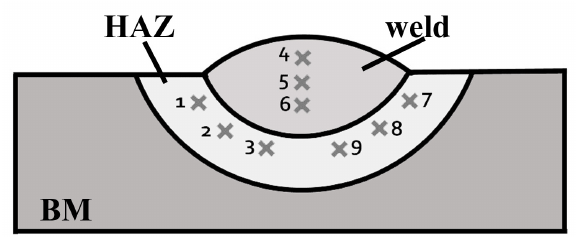
Figure 3. Vickers HV10 measurements distribution points.